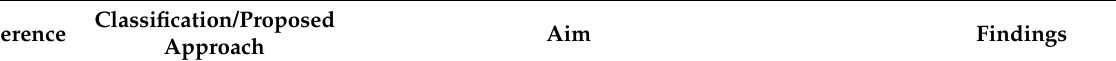
Table 1. Literature review